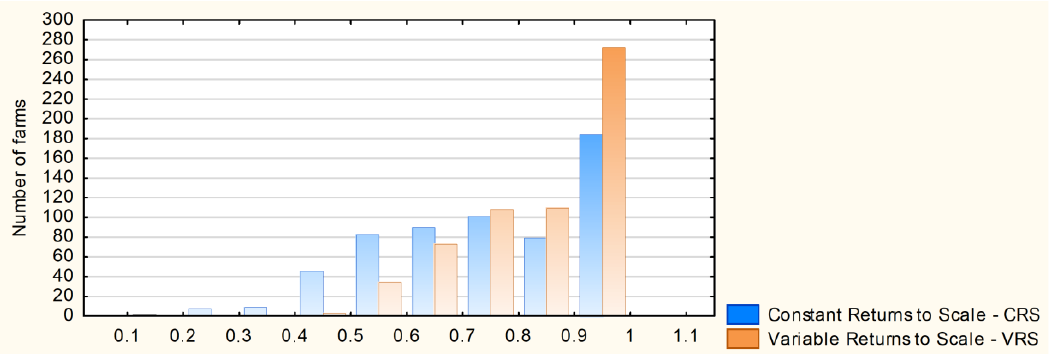
Figure 1. E ffi ciency indicators distribution in the sample of Polish commercial Figure 1. Efficiency indicators distribution in the sample of Polish commercial farms. Table 4. Average eco-efficiency indicators calculated with the data envelopment analysis (DEA) method, depending on production type and economic size classes, and the share of fully efficient farms in the sample of Polish commercial farms.